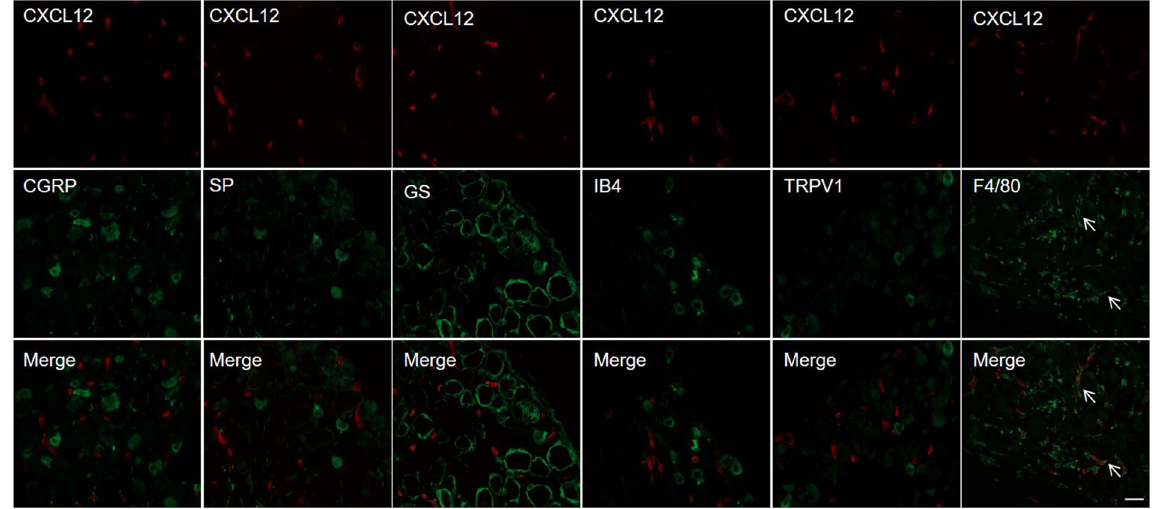
Figure 3. Immunoreactivity for CXCL12 was detected in the macrophages (F4/80) (arrows in merged image), barely co-localized with nociceptive neurons and satellite glial cells from CCD CXCL12 DsRed knock-in mice on postoperative day 7. Scale bar: 50 μ